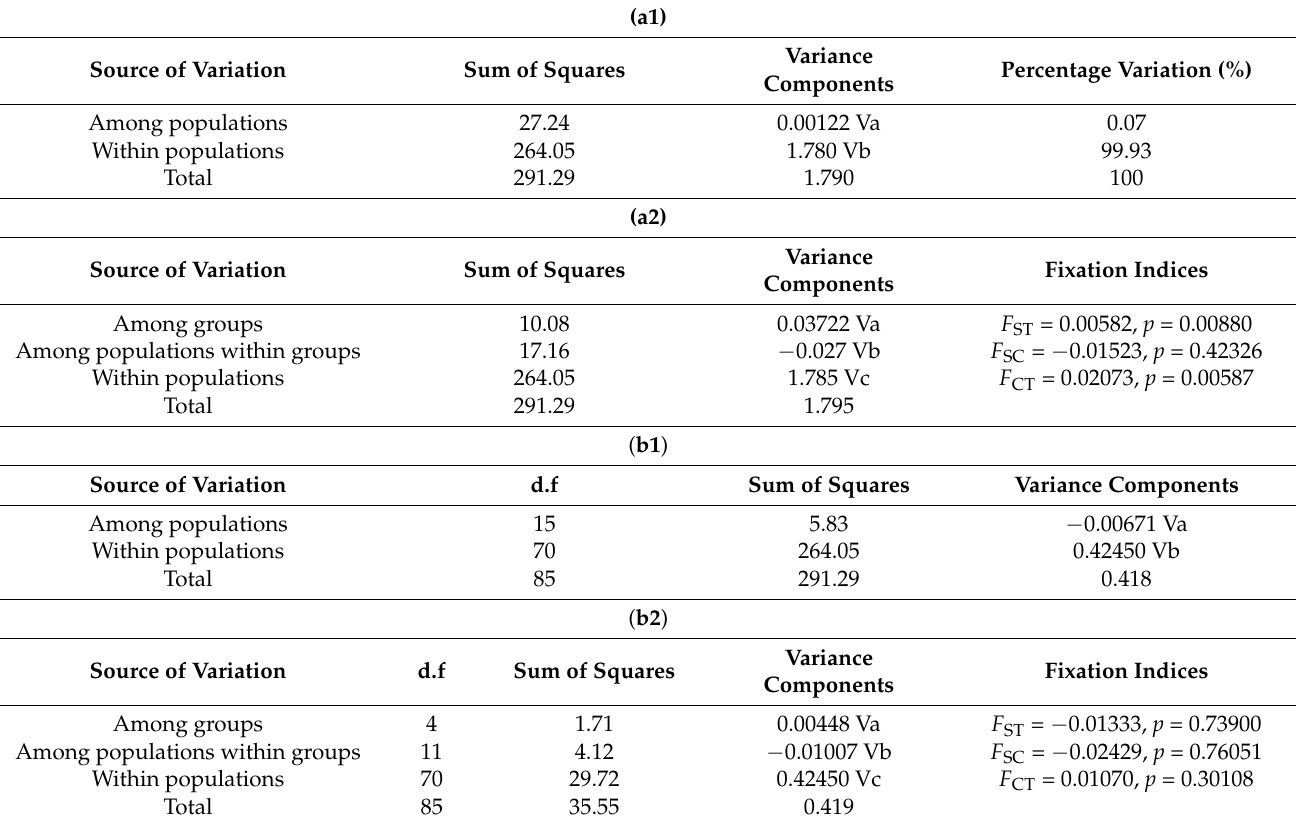
Table 7. ( a1 ): Non-hierarchical AMOVA for all the sixteen populations of O. mutabilis , and ( a2 ) hier- archical AMOVA for all the sixteen districts grouped into five agro-ecological zones based on SSR data; ( b1 ) non-hierarchical AMOVA for all sixteen populations of O. mutabilis, and ( b2 ) hierarchical AMOVA for all the sixteen populations grouped into their relative agro-ecological zones based on mt COI